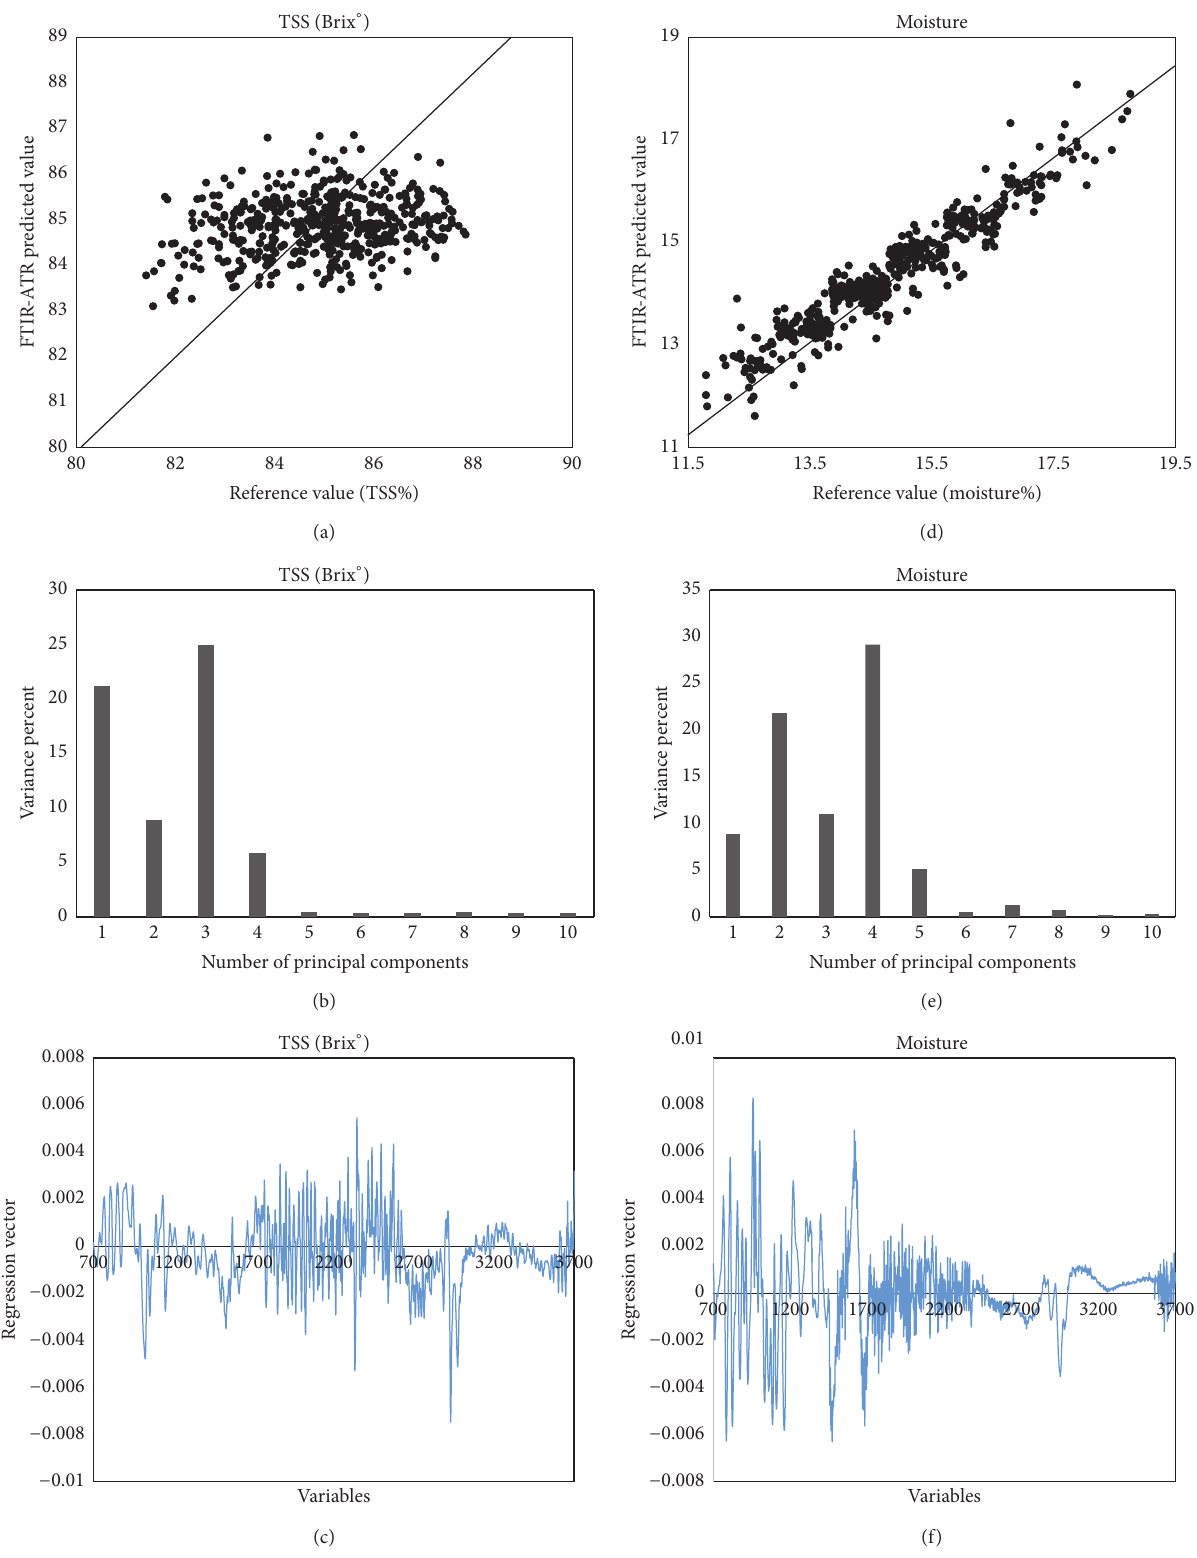
Figure5:PLSvalidationplotsofTSS(Brix ∘ ),contributionofPCA,andregressionvector(a)–(c);PLSvalidationplotsofmoisturecontribution of PCA and regression vector